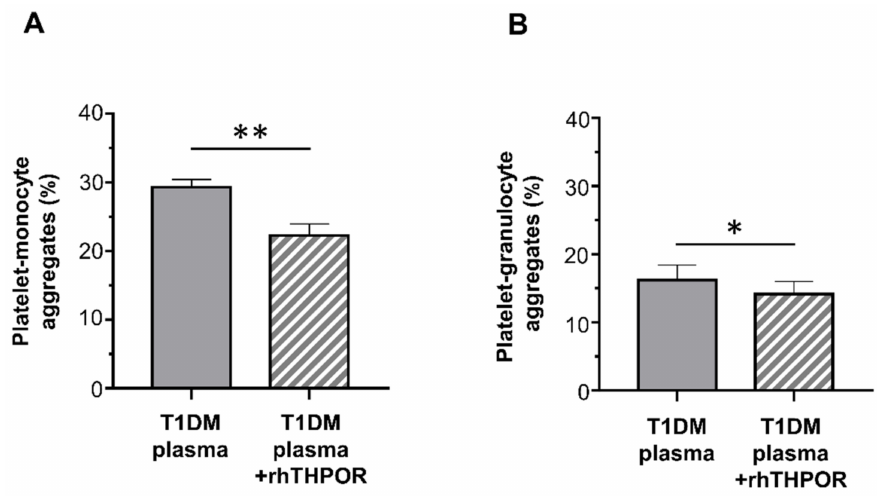
Figure 5. Effect of recombinant human (rh)THPOR on the priming activity induced by plasma from type 1 diabetic patients on EPI-induced platelet–monocyte ( A ) and platelet–granulocyte binding ( B ), as analyzed by flow cytometry in whole blood. Data were represented as mean ± SE. p -values by paired t -test (( A ) ** p < 0.01; ( B ) * p <